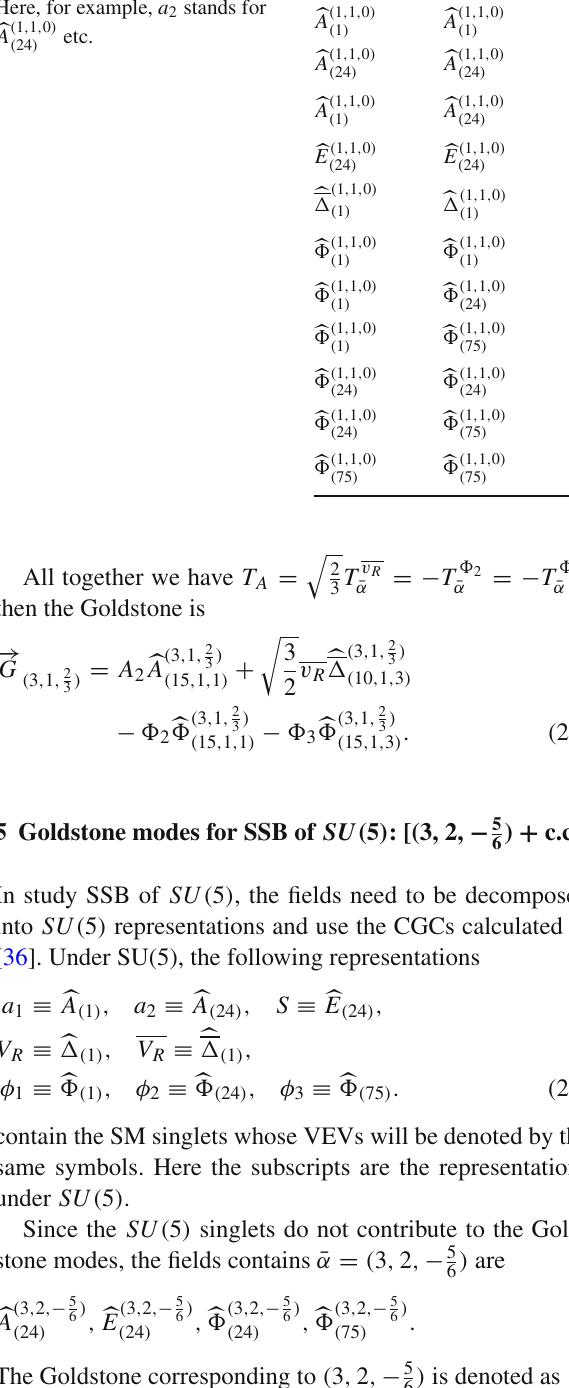
Table 5 CGCs for the SM singlets (1, 1, 0) under SU ( 5 )